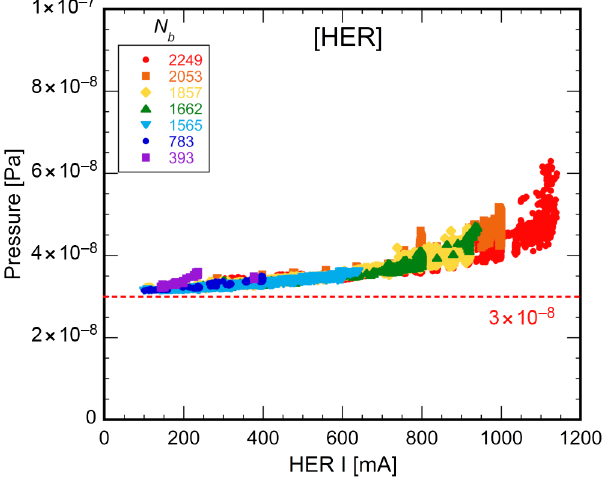
FIG. 10. Dependences of P on I for N b of 393 – 2249 for the HER from the 19th of May to the 22nd of June